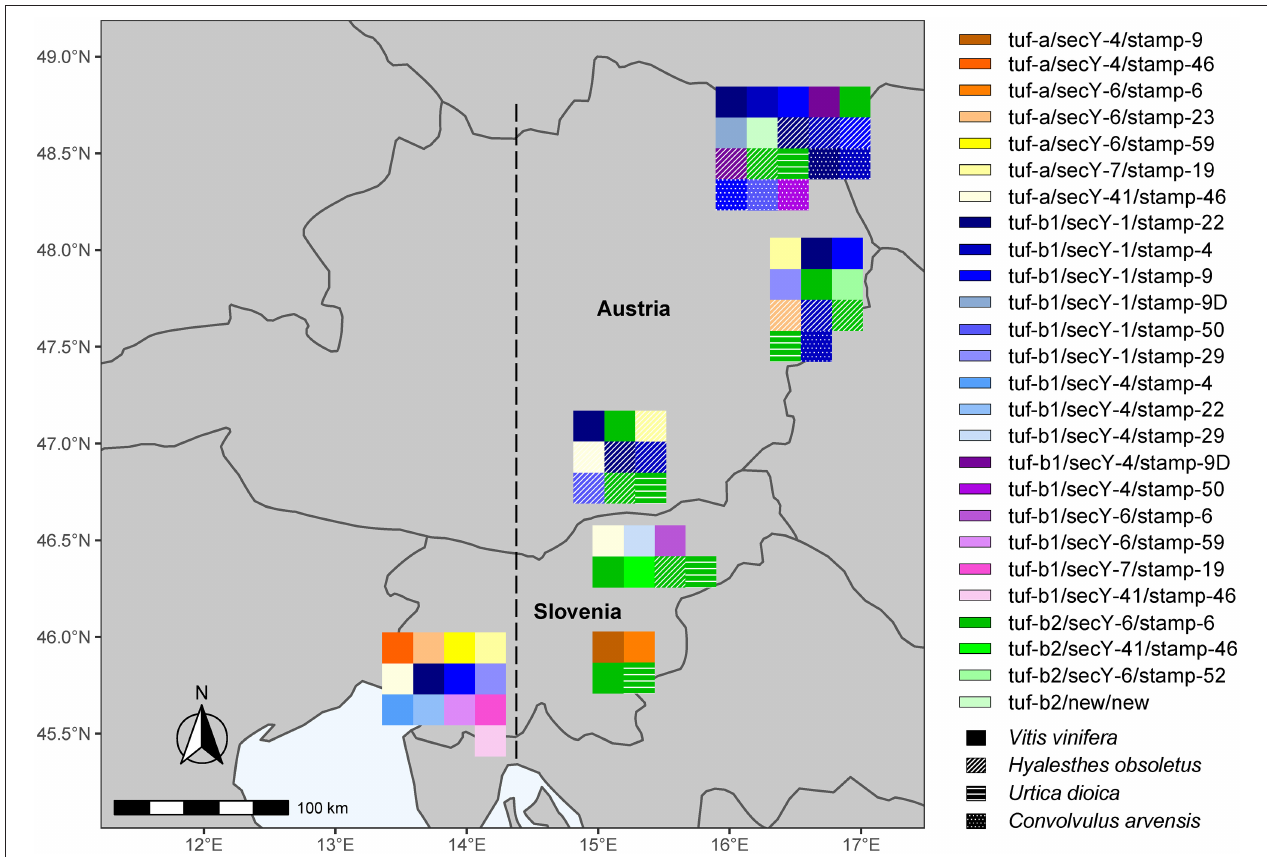
FIGURE 3 | All detected haplotypes of “ Ca . P. solani” in wine-growing regions in Slovenia and Austria. The line denotes the Italian-Slovenian Karst